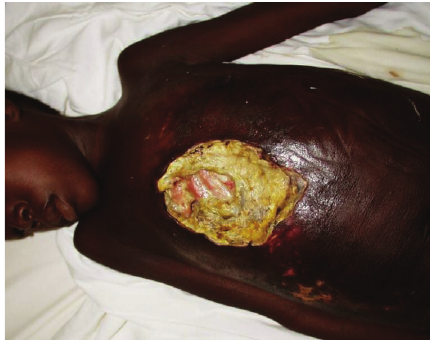
Figure 1: Thoracic BU revealing the ribs of an 8-year-old girl.